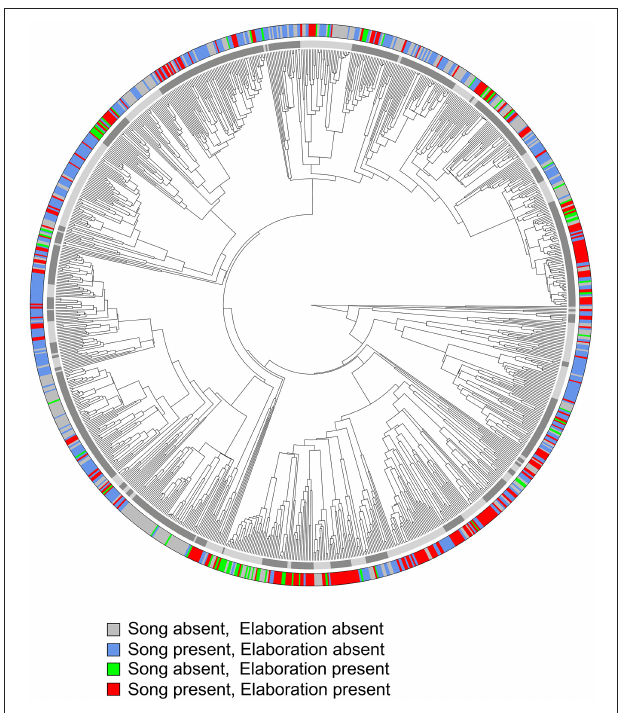
FIGURE 2 | Phylogenetic distribution of female song and female plumage elaboration. Plumage elaboration is here treated as a binary character with cutoff = plumage score of 50. Red labels represent species where female song and female plumage elaboration (plumage score > 50) co-occur. The inner ring of alternating gray tones depicts boundaries of the 86 oscine families in our sample.